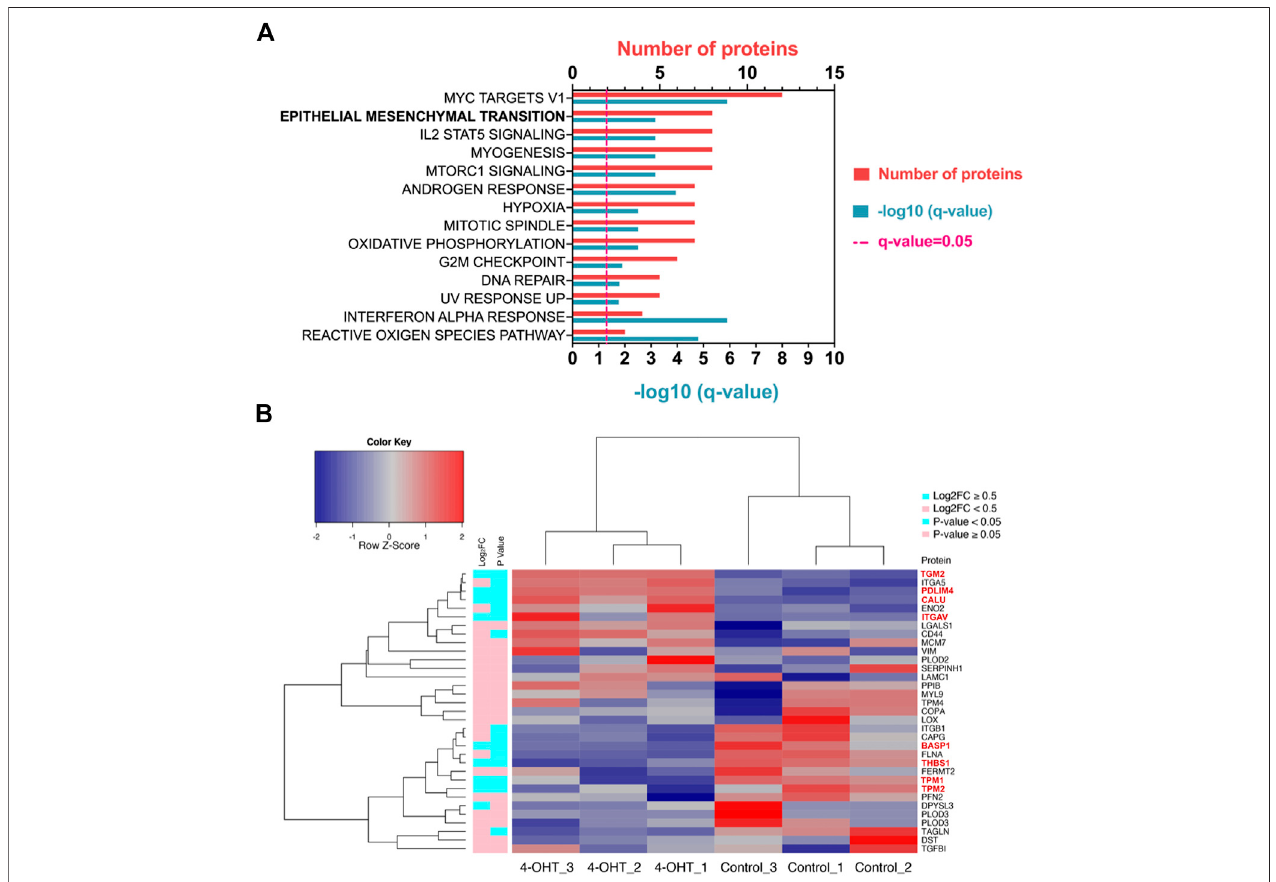
FIGURE 1 | RAS-activation in ATII cells induces Hallmark EMT proteomic signature (A) Pathway analysis in Metascape (Metascape.com) analyzing differentially expressed proteins (DEPs) in ATII ER:KRASV12 cells treated with 250 nM 4-OHT or control for 24 h, all non-signi fi cant pathways have been removed from diagram. (B) Heatmap and hierarchical cluster analysis of ATII ER:KRASV12 cells treated with 250 nM 4-OHT (RAS-activated) compared with control for 24 h, a panel of hallmark EMT proteins were evaluated. p Value (blue: p Value < 0.05, pink: p Value ≥ 0.05). | log 2 fold change (blue: | log 2 FC | ≥ 0.5, pink: | log 2 FC | < 0.5). Red text indicates differentially expressed proteins